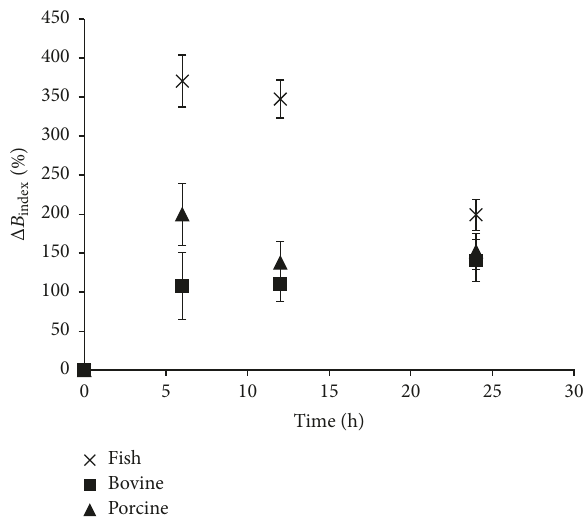
: change in brown- index